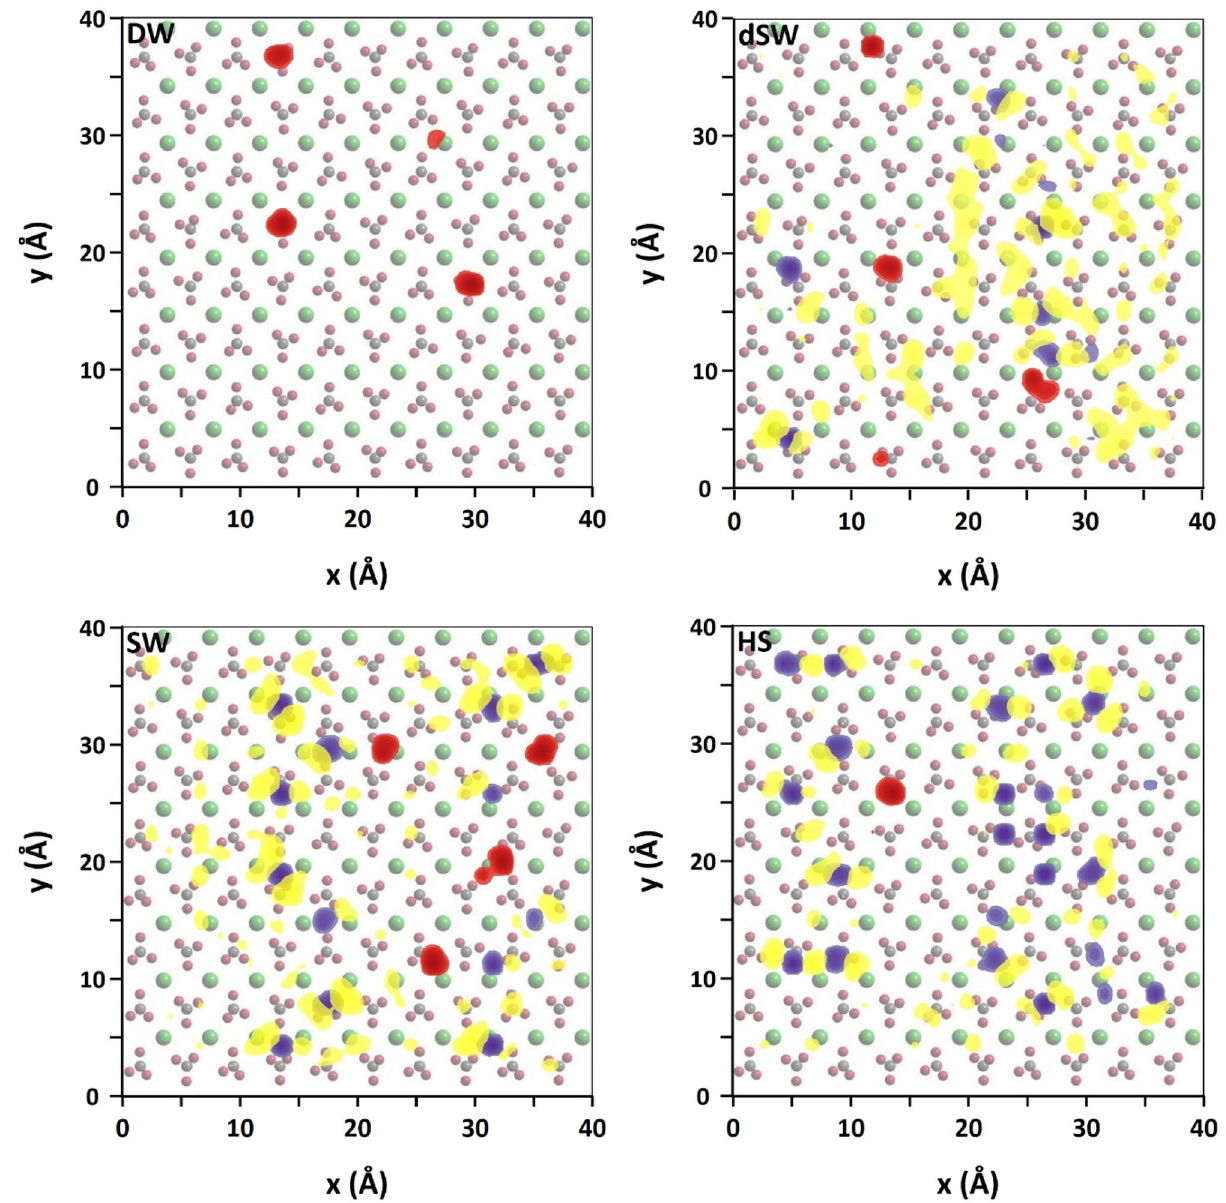
Figure 10. 2D lateral density profile of Na + (purple), Cl − (yellow) and BA (red) at calcite/water interface at different salinities superimposed over the topmost calcite